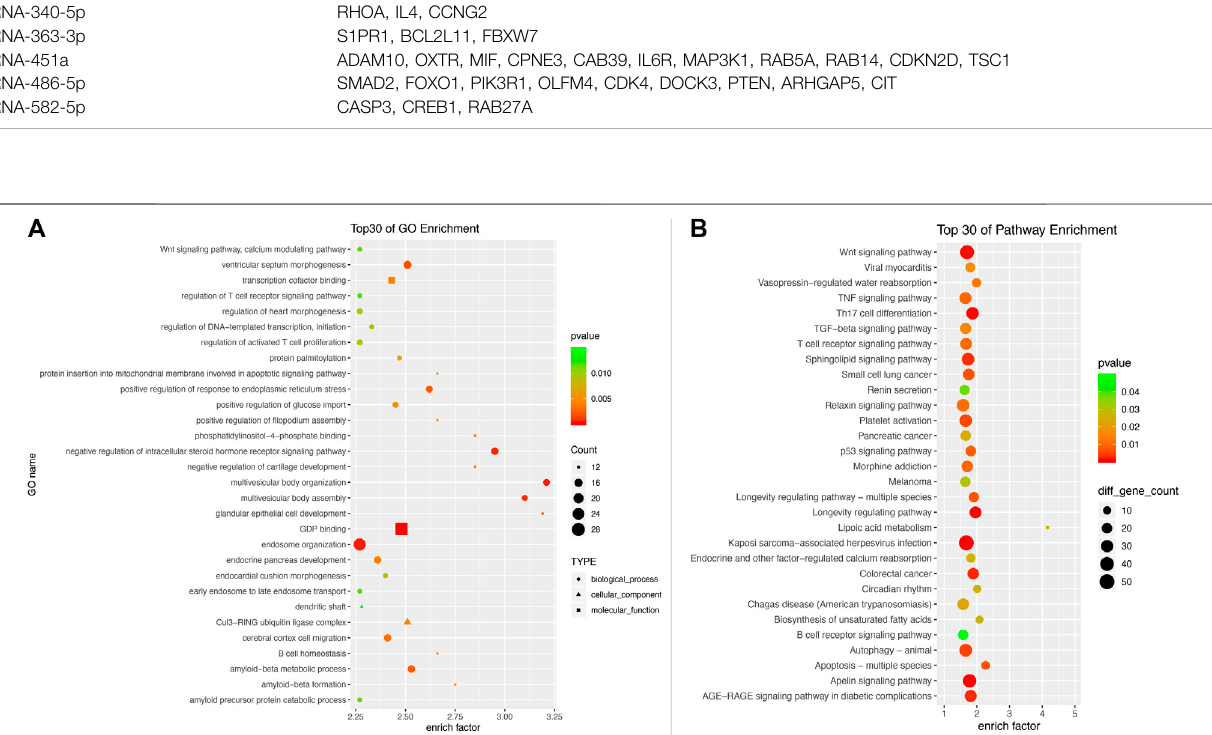
Frontiers in Genetics |